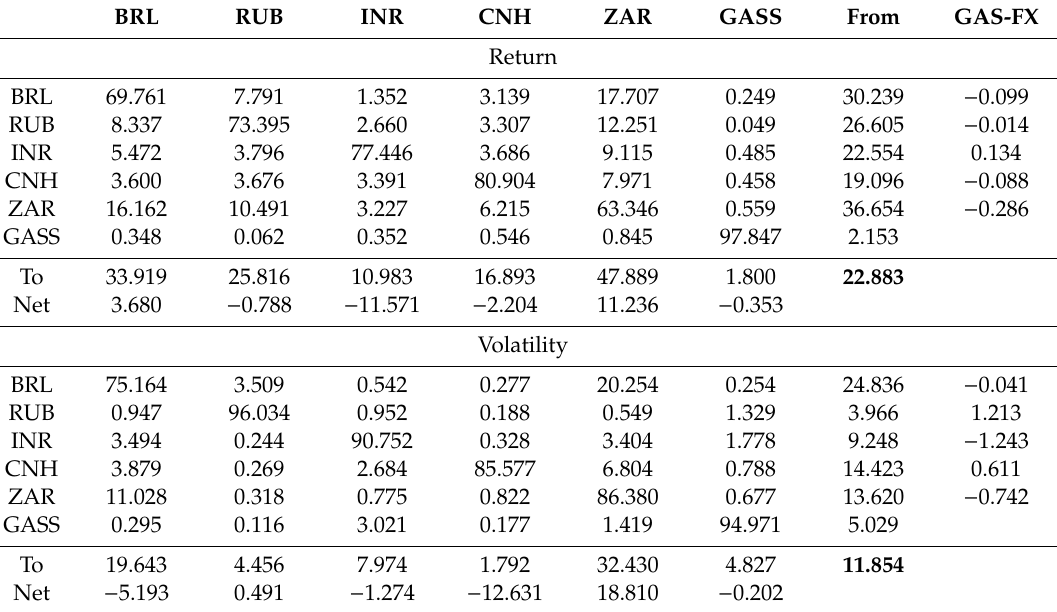
Table A2. Connectedness between the UK NBP and BRICS’s exchange